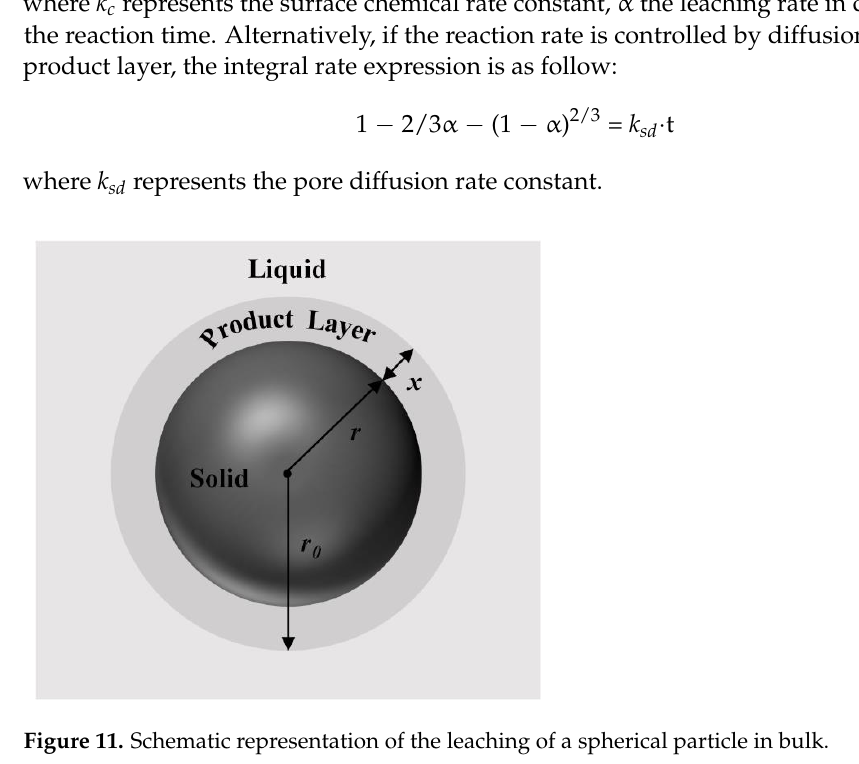
Figure 10. Leaching recoveries of REEs at different leaching temperatures (( a ), 30 °C; ( b ), 60 °C; ( c ), 80 °C) as a function of leaching time under the conditions of 1.65 mol/L HCl and S/L ratio of 1/10.